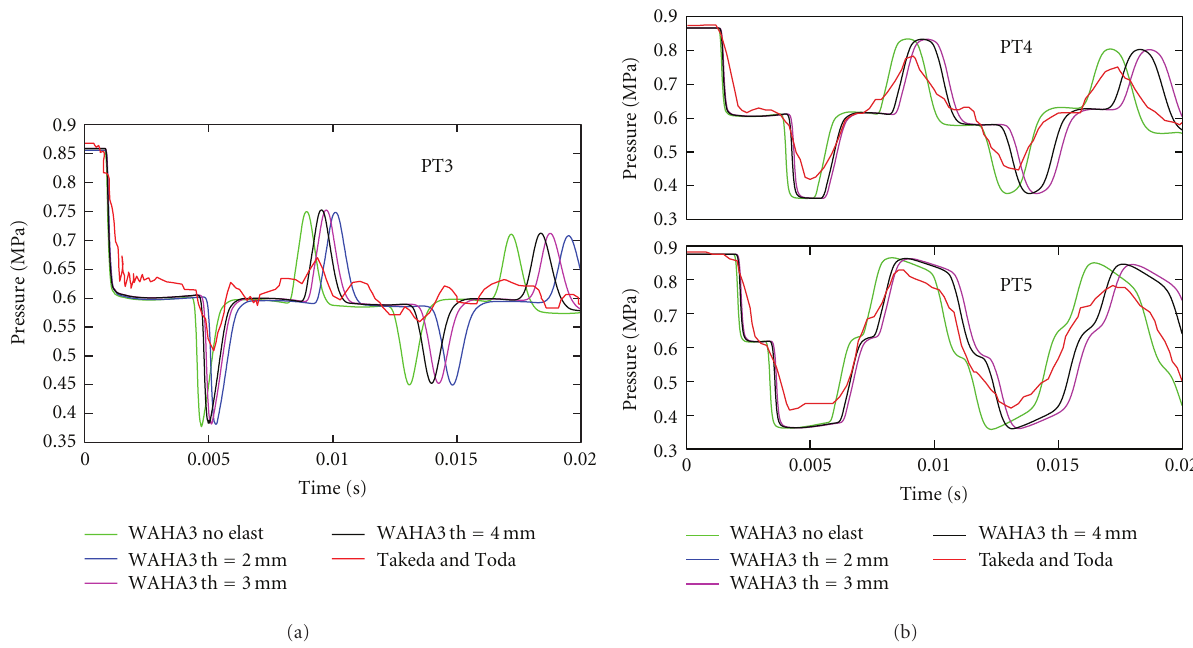
Figure 7: Pressure readings at PT3 (a), PT4 and PT5 (b) compared with